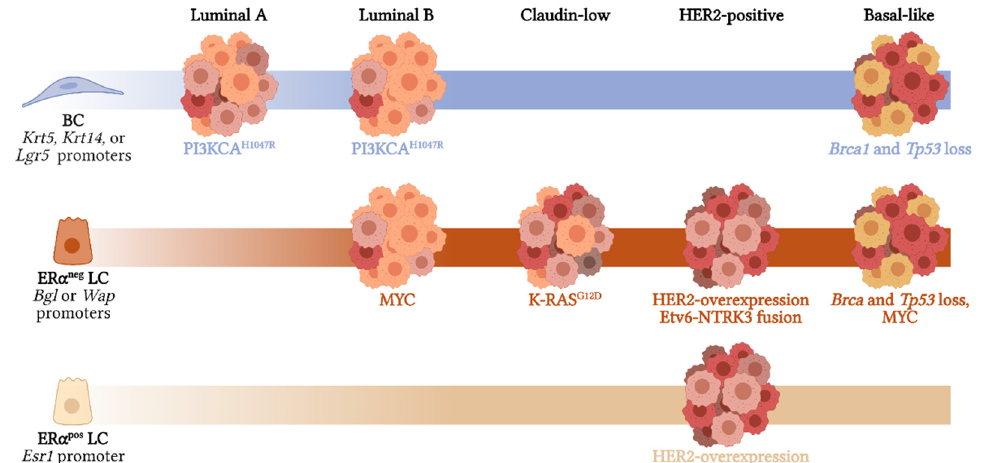
Figure 4. Schematic representation of the mammary cellular plasticity during tumorigenesis. The use of different murine Cre lines ( Lgr5 -Cre ERT2 , Krt5 -Cre ERT2 or Krt14 -Cre to target BCs; Bgl -Cre or Wap -Cre to trace ER α neg LCs; and Esr1 -Cre to monitor ER α pos LCs) to induce the expression of specific mutations in different mammary epithelial cell types resulted in the generation of tumors that resembled some of the human subtypes: luminal A [43], luminal B [43,89], HER2-enriched [48,66], claudin-low (or mesenchymal-like) [96], and basal-like [18,73] tumors. Notes: this figure only includes studies that have used comparisons with human breast cancer transcriptomic datasets (PAM50, Hu306 or similar); studies performed with non-specific Cre lines, such as MMTV -Cre or Krt8 -Cre ERT2 (which labels all MECs, or both LC populations, respectively), were discarded. This figure was created with Biorender.com (accessed on 12 December 2021).